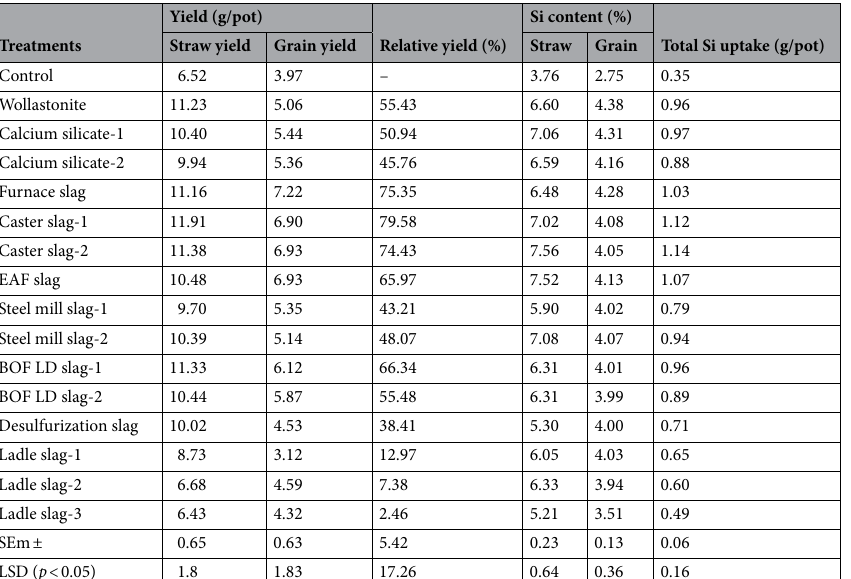
Table 3. Effect of slags on yield, Si content and Si uptake of wetland rice.